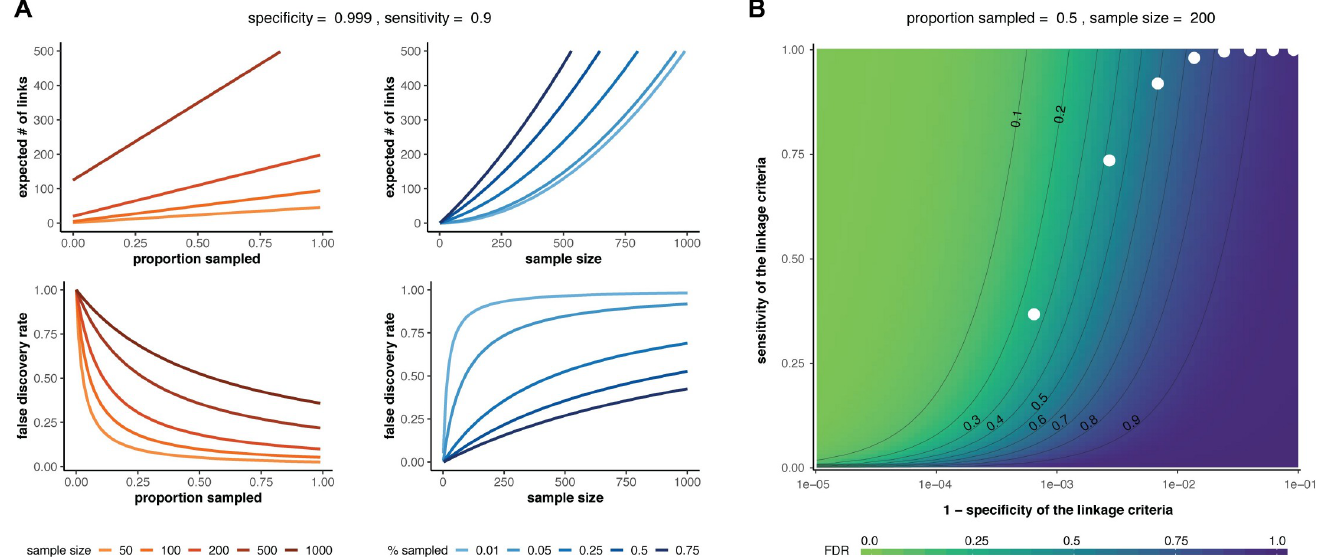
Fig 1. Sample size and false discovery rate given multiple linkage and multiple transmissions. ( A ) Effect of sample size (red lines) or proportion sampled (blue lines) on the expected number of linked pairs (upper plots) or the false discovery rate of linked pairs (lower plots). The specificity and sensitivity are held constant. ( B ) Effect of varying the sensitivity and specificity of the linkage criteria on the false discovery rate (FDR). White dots: theoretical sensitivity and specificity values at different genetic distance thresholds (1–10 substitutions between infections; leftmost white dot represents a threshold of 1 substitution) for a hypothetical pathogen with substitution rate = 1 substitution/genome/transmission and R = 2 (see ‘Determining sensitivity and specificity’ below for details). In both panels, R pop = 1.